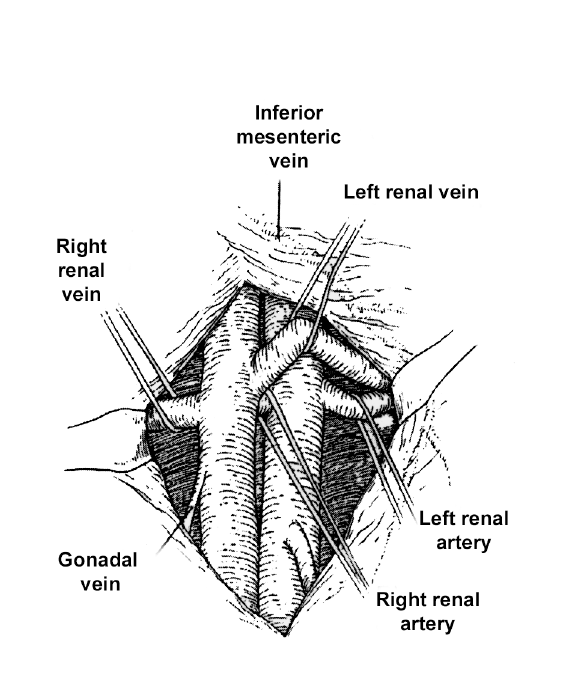
Figure 3 - Anatomic relationship of the renal vessels. (Reprinted with permission from: McAninch JW: Surgery for Renal